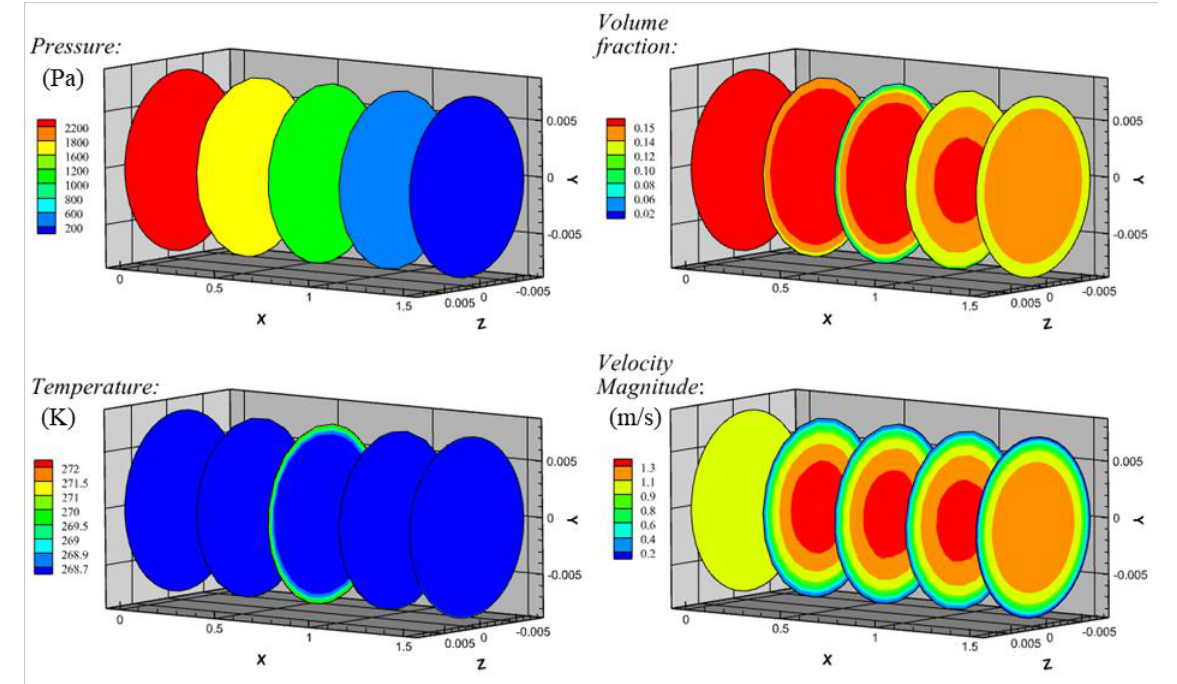
Figure 7. Distribution of IVF, solid velocity, pressure and temperature at different cross-sections with local large heat flux value of 40 kW/m 2